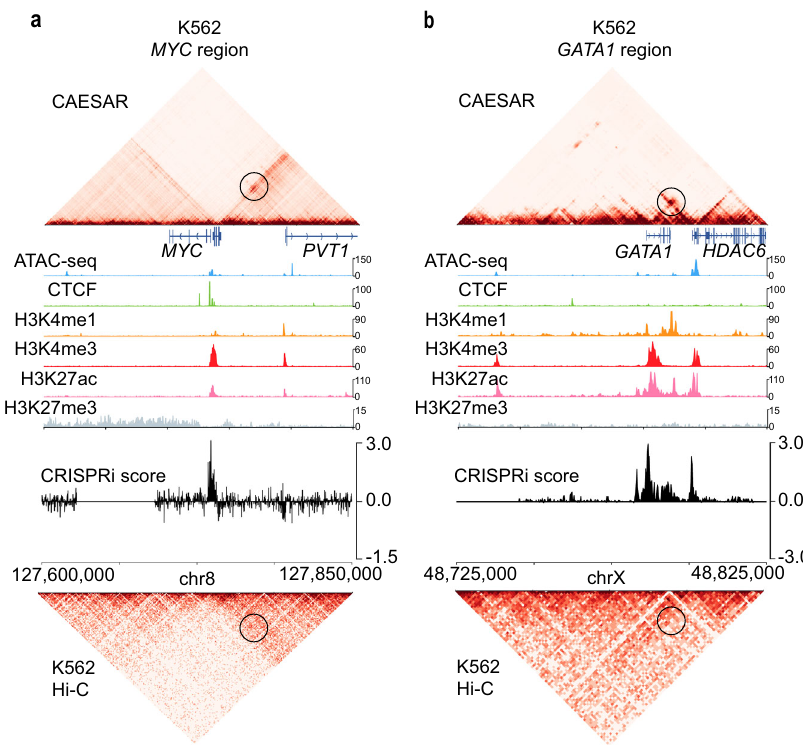
Fig. 4 The interactions between genes and their CRISPRi-validated enhancers in CAESAR-imputed contact maps. a The CAESAR-imputed contact map of K562 at MYC region (chr8: 127,600,000 – 127,850,000) demonstrates signi fi cant contacts between MYC and PVT1 , which agree with CRISPRi score peaks, but are not shown on the original input Hi-C contact map. The magnitude of the epigenomic features is the observed value divided by the genome- wide average. b The CAESAR-imputed contact map of K562 at GATA1 region (chrX: 48,725,000 – 48,825,000) demonstrates signi fi cant contacts between GATA1 and HDAC6 , which agree with CRISPRi score peaks, but are not shown on the original input Hi-C contact